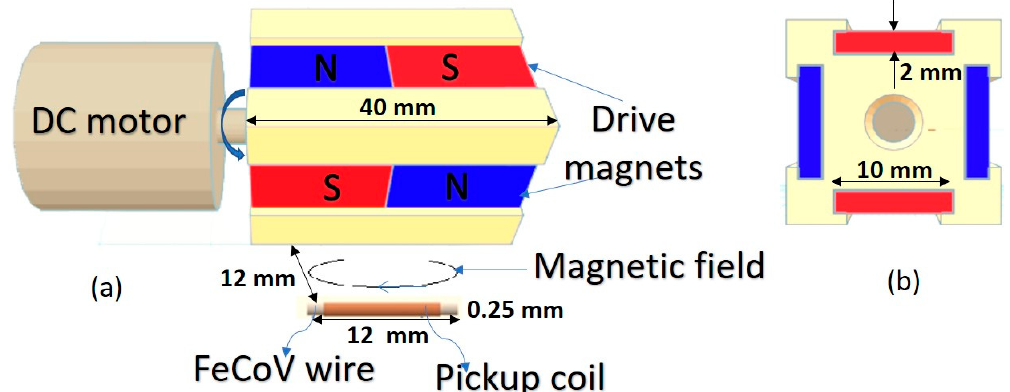
Figure 1. A Weigand sensor (FeCoV wire and pickup coil) and the arrangement used (( a ) front view Sensors 2020 , 20 , x FOR PEER REVIEW and ( b ) side view) to generate electrical power.